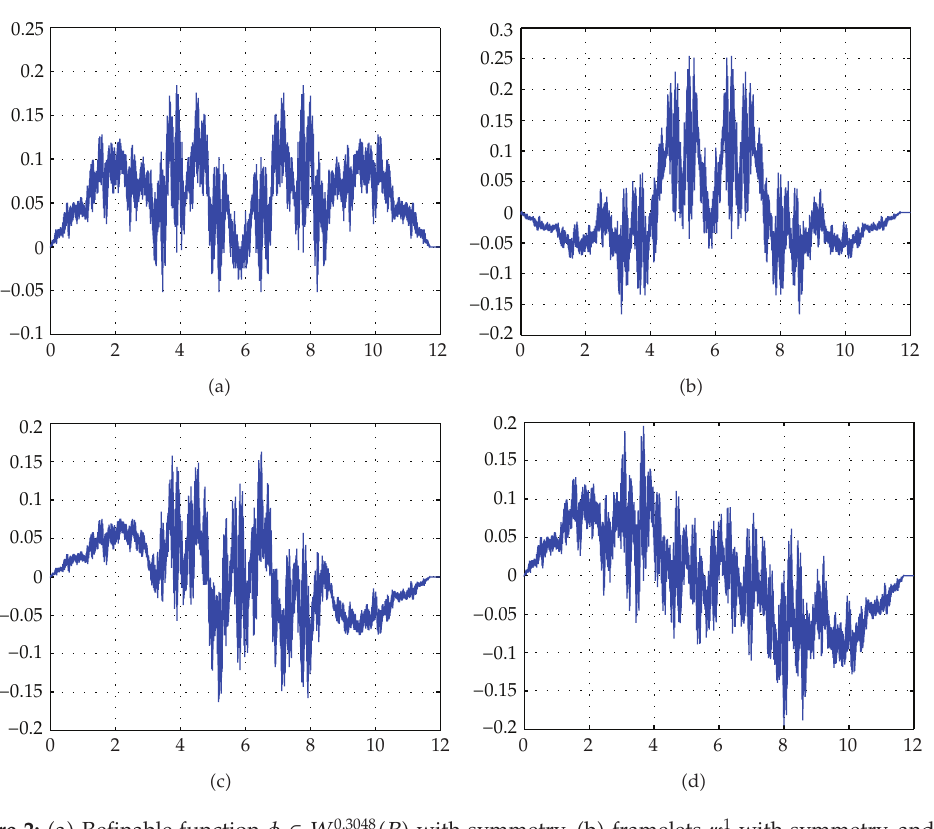
Figure 2: (cid:6) a (cid:7) Refinable function φ ∈ W 0 . 3048 (cid:6) R (cid:7) with symmetry, (cid:6) b (cid:7) framelets ψ 1 with symmetry, and (cid:6) c (cid:7) and (cid:6) d (cid:7) ψ 2 symmetry and ψ 3 with antisymmetry, respectively.